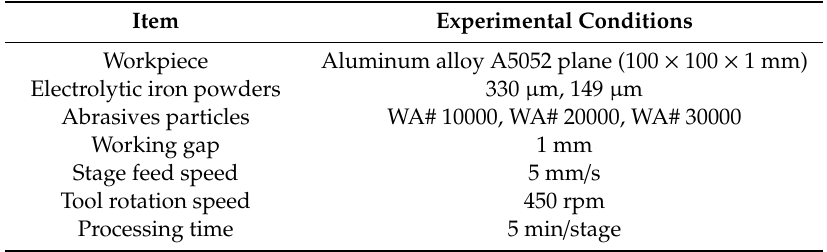
Table 2. Experimental conditions of magnetic abrasive finishing (MAF)